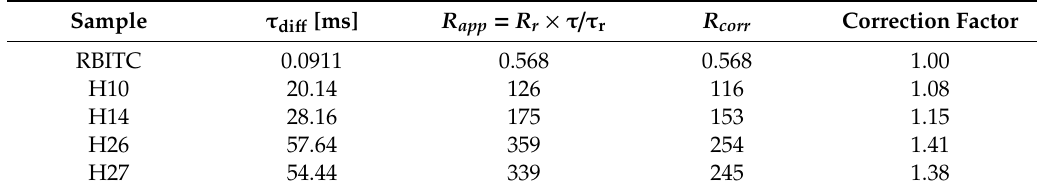
Table 4. FCS correlation times τ diff , apparent hydrodynamic radii R app , corrected hydrodynamic radii R corr and the values of the correction factor.